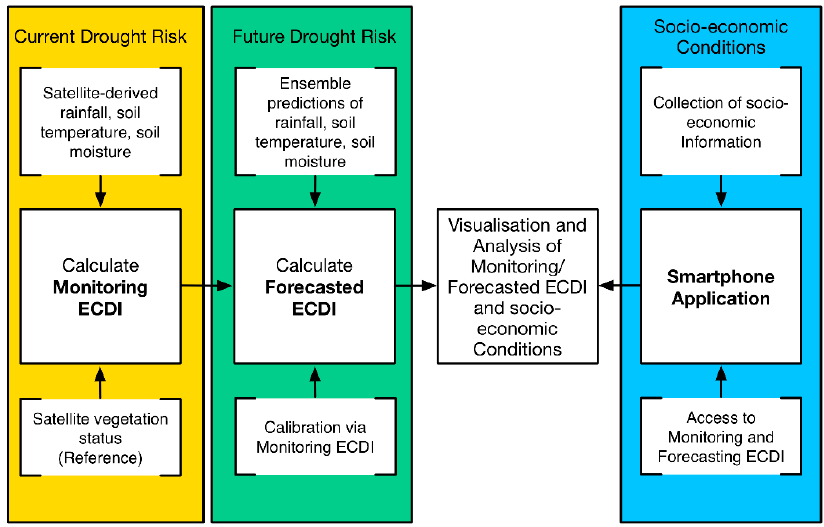
Figure 1. The schematic framework of the SATIDA (Satellite Technologies for Improved Drought-Risk Assessment) research project.